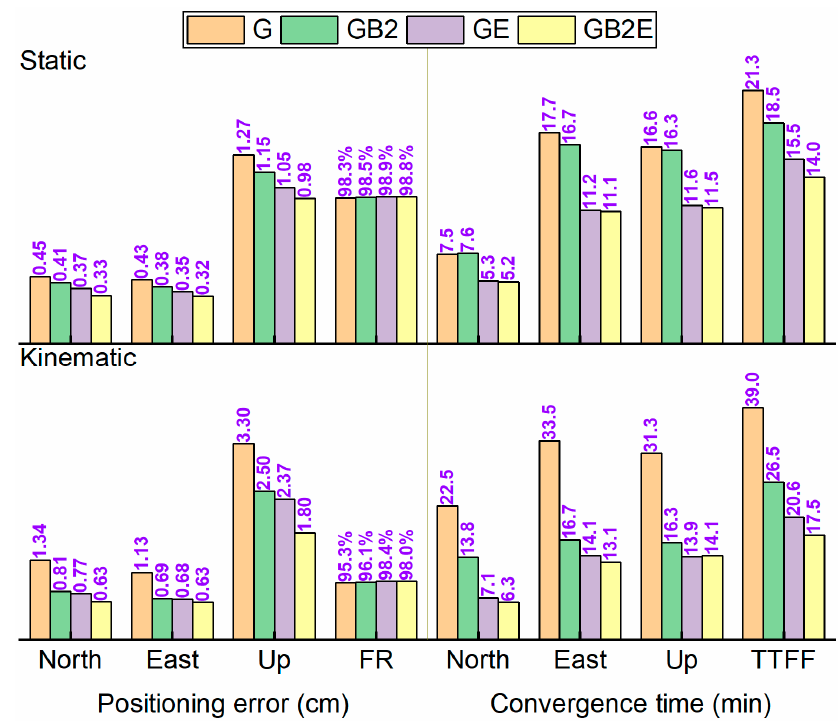
Figure 8. Average performance of multi-GNSS PPP AR in static ( top ) and kinematic ( bottom ) mode with WUM products. FR is defined as the ratio of the number of fixed epochs to the number of total epochs after TTFF and TTFF means time to first fix. The specific value is recorded at the top of the bar.